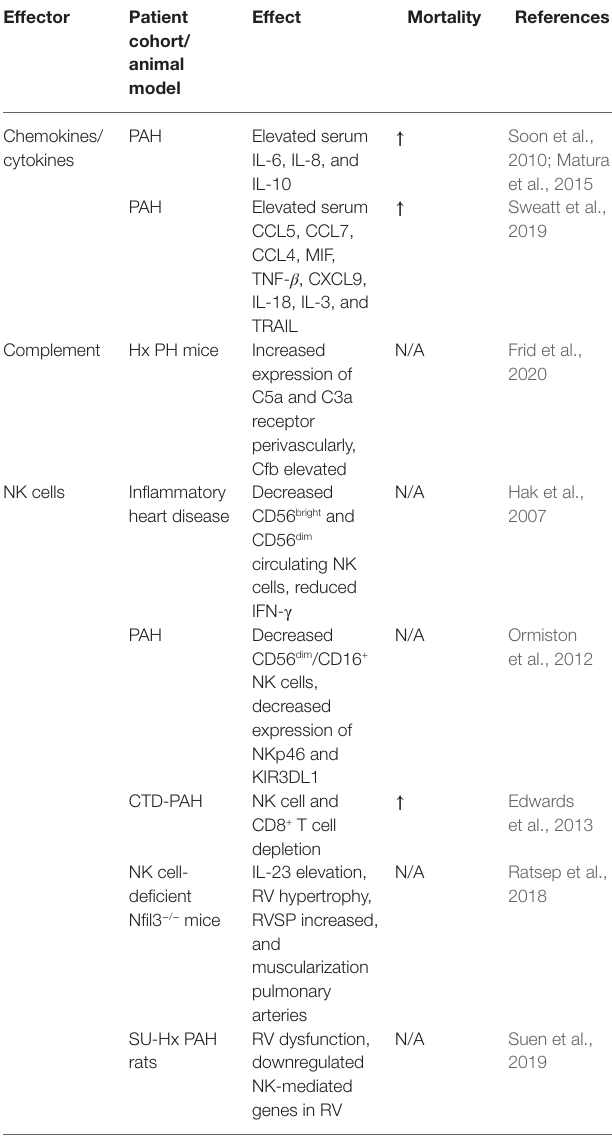
TABLE 1 | Summary of the most important humoral mediators of perivascular inflammation in pulmonary hypertension (PH) and findings regarding natural killer (NK)